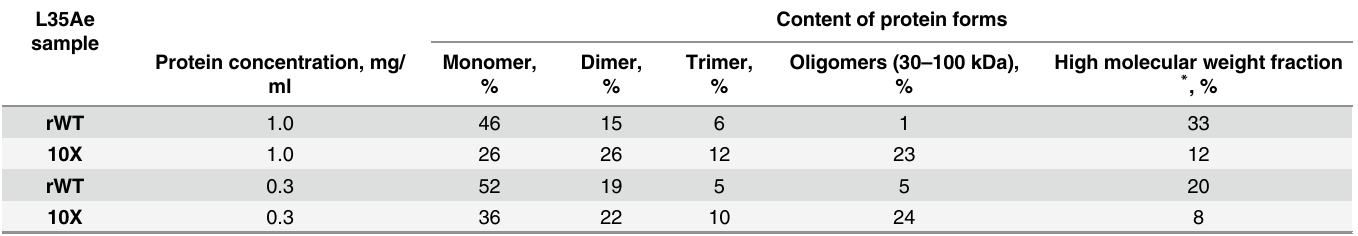
Table 3. Distributions of oligomeric forms for rWT L35Ae and L35Ae 10X proteins measured by SDS-PAGE (4 – 15%) of the proteins, subjected to crosslinking with 0.05% glutaraldehyde at 37°C for 1 h. L35Ae